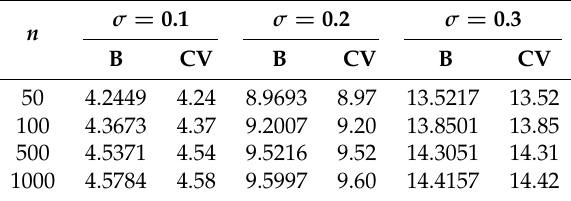
Table 6. European floating strike currency lookback option prices in the Black–Scholes framework. σ = 0.1 σ = 0.2 σ = 0.3 n B CV B CV B